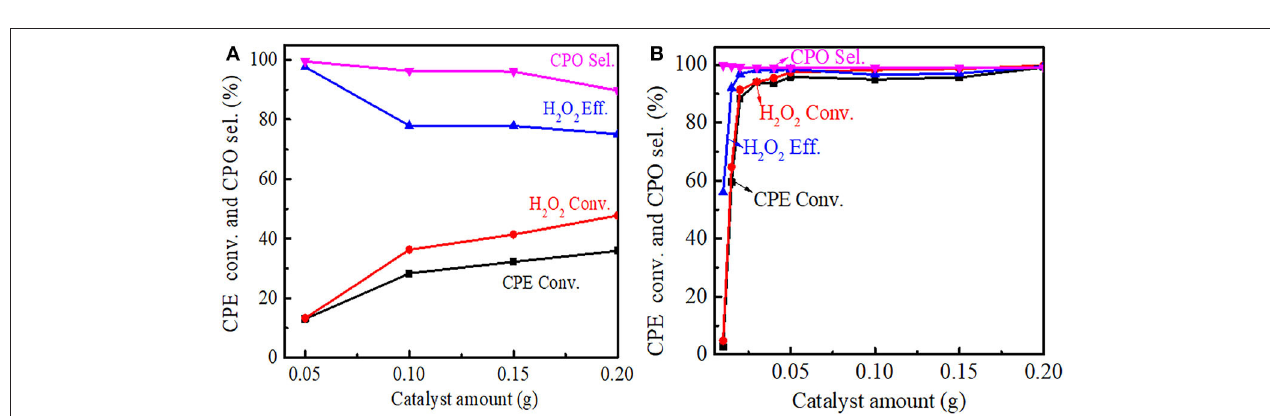
FIGURE 7 | Ti 2p XPS spectra (A) of Ti-MWW-AM (a), Ti-MWW-AT (b), Ti-MWW (c), R-Ti-MWW-PI (d), and R-Ti-MWW-PI-cal (e) and N 1s XPS spectra (B) of Ti-MWW-AM (a), Ti-MWW-AT (b), and R-Ti-MWW-PI (c).